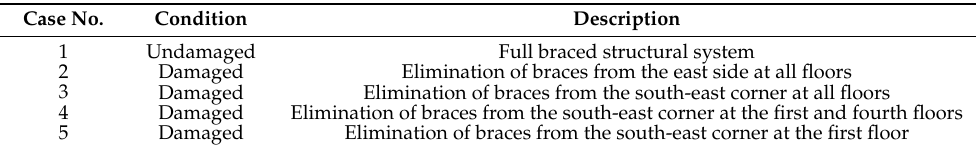
Table 2. ASCE problem: structural features of the undamaged and damaged conditions. Case